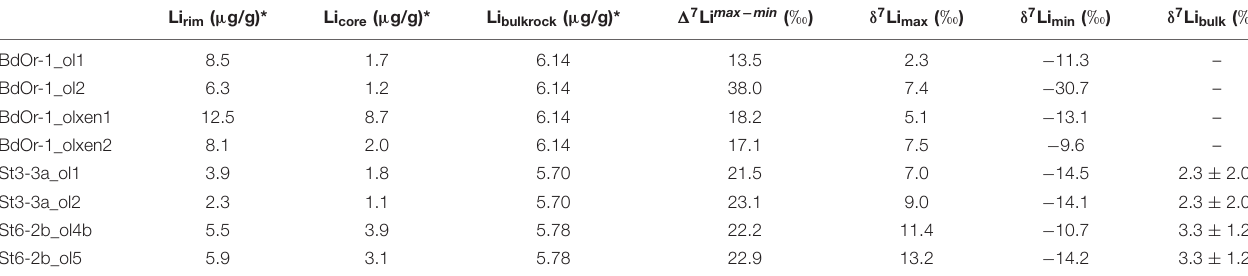
TABLE 1 | Lithium rim and core compositions of investigated